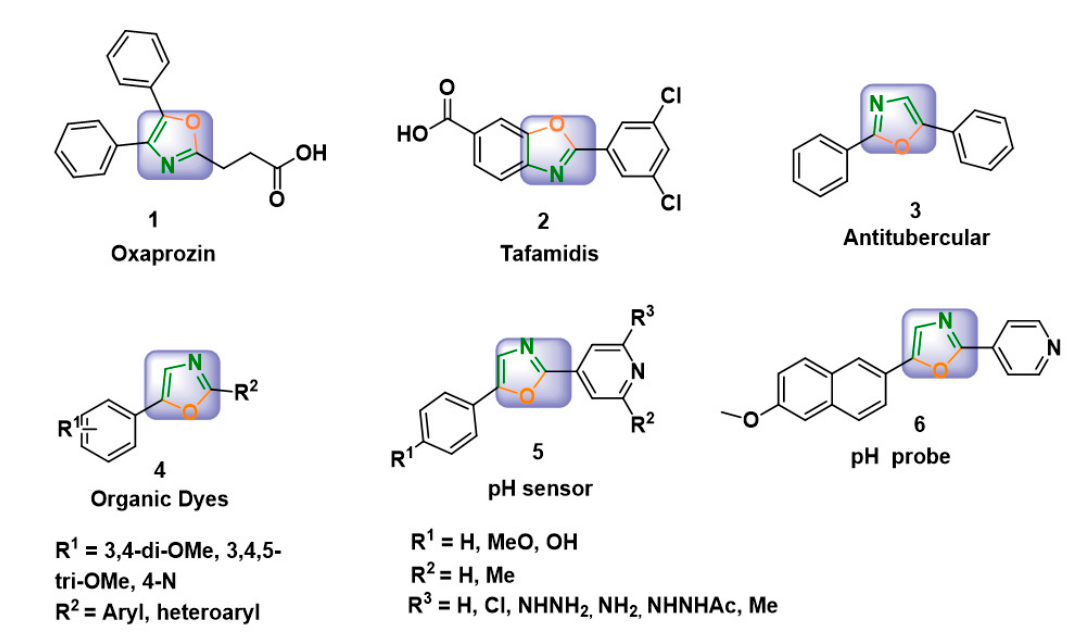
Figure 1. Several examples of bioactive, medicines and fluorescent compounds containing 1,3-oxazole